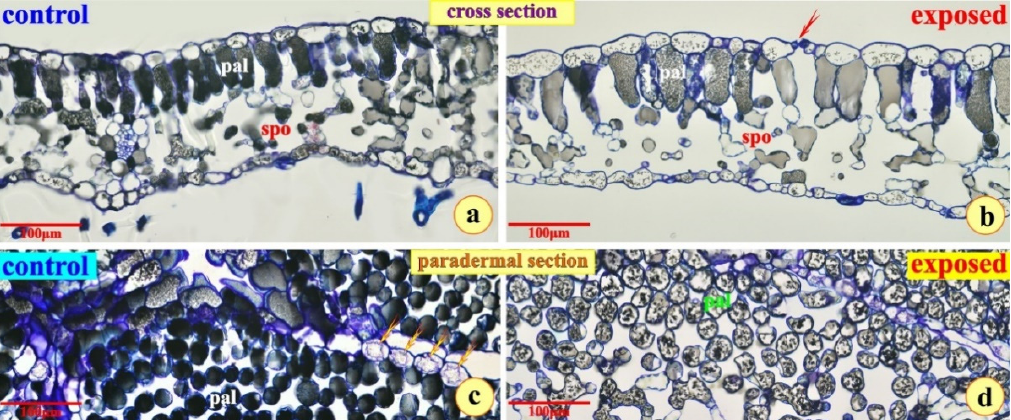
Figure 6. Cross-sections of a leaf from ( a ) a control plants and ( b ) an exposed plant. Paradermal sections from a leaf of ( c ) a control plant and ( d ) an exposed plant. pp = Palisade parenchyma, sp = spongy parenchyma. Red arrow points at a stoma on the adaxial surface, yellow arrows point at idioblasts with crystals. (All scale bars are 100 μ m).